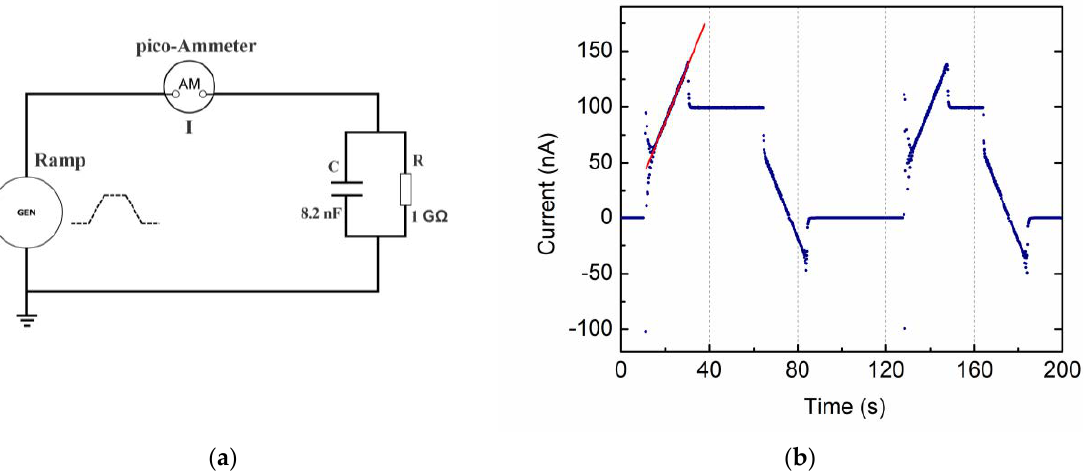
Figure 4. VRM applied to a slice of HD PTFE 2 mm thick. A 10 V/s voltage ramp is applied up to a flat top of 500 V; the output current (blue marks) shows the expected behavior for a real capacitor. Linear fits (red lines) to the top and bottom flat current intensity plateau are also shown.